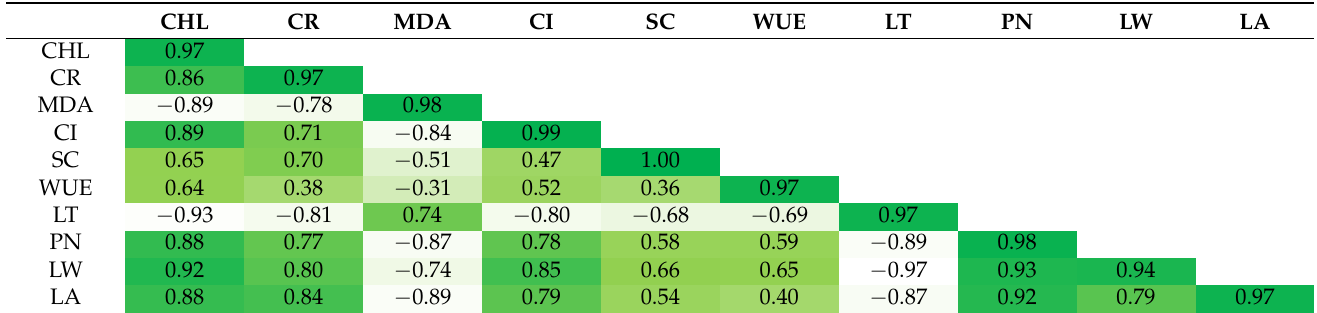
Figure 6. Chlorophyll fluorescence (Fv/Fm) value of WT-MT, iaa9-3 , and iaa9-5 under normal and heat stress conditions. The average value ± standard error (SE) ( n = 4) followed by the same letter is not significantly different according to the Tukey-HSD test at 5%. Table 1. Pearson correlation between analyzed traits under heat stress